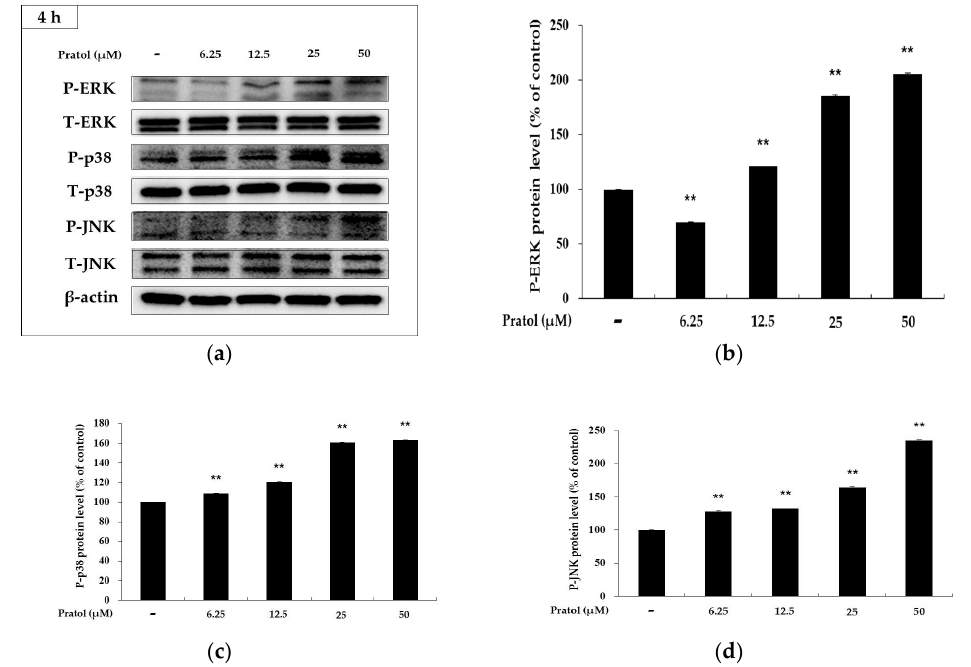
Figure 7. Effects of pratol on the phosphorylation of p-ERK, p-p38, and p-JNK. B16F10 cells were treated with pratol at the indicated concentrations for 4 h. ( a ) Result of western bolting, and protein level of ( b ) p-ERK, ( c ) p-p38 and ( d ) p-JNK. The data are presented as mean ± SD of at least three independent experiments. ** indicates p < 0.01. P: Phosphorylated, T: Total.